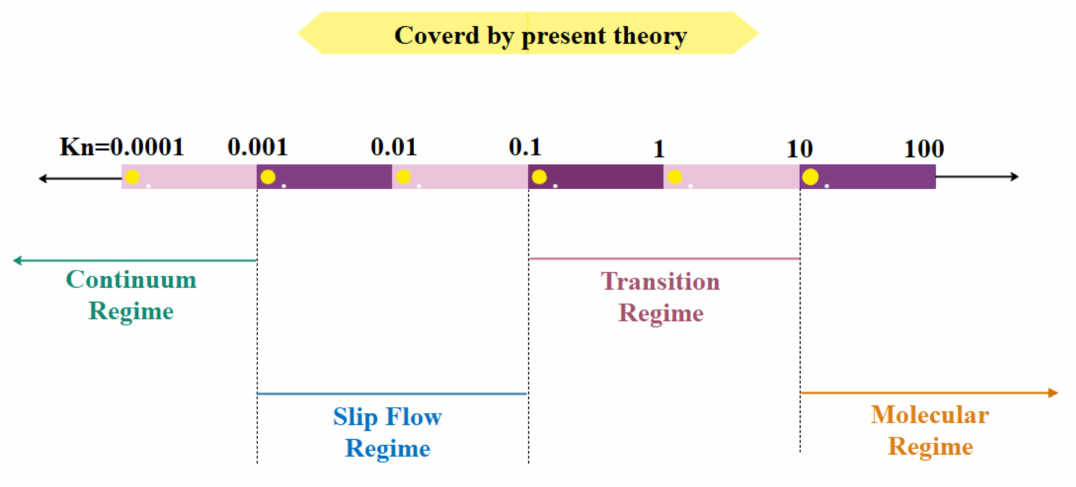
Figure 3. Flow regimes based on Knudsen number